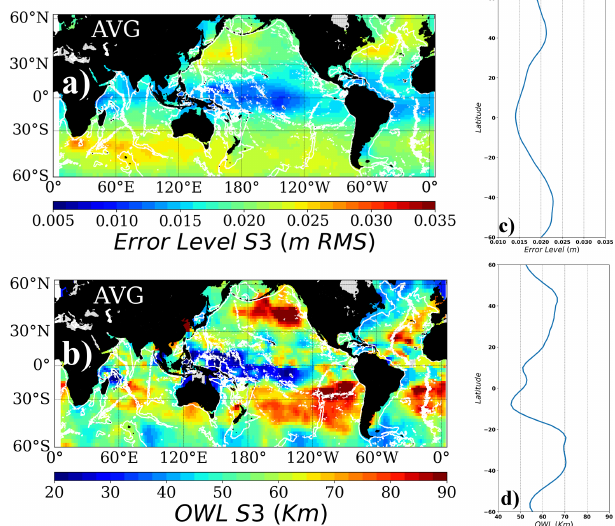
Figure 2. Same as Fig. 1, but for Sentinel-3A